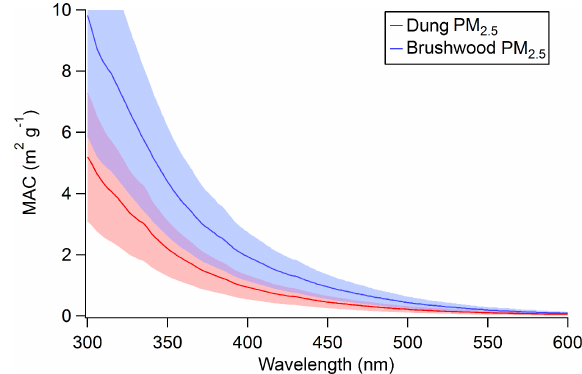
Figure 6. Possible structures of N-heterocyclic PAHs found in dung cook fire emissions. C 13 H 9 N was detected reproducibly in dung– chulha emissions only, while C 12 H 9 ON and C 11 H 8 N 2 were repro- ducibly detected in all dung cook fires.